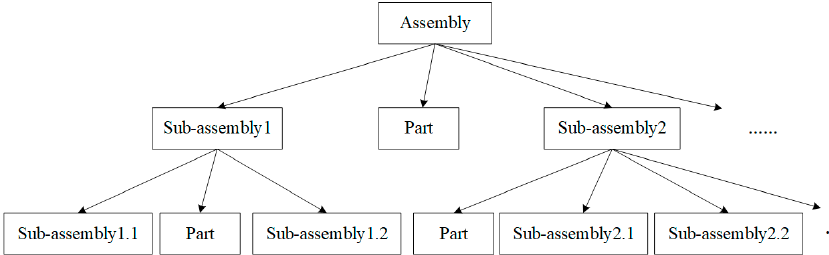
Figure 4. Overall structure of assembly model.